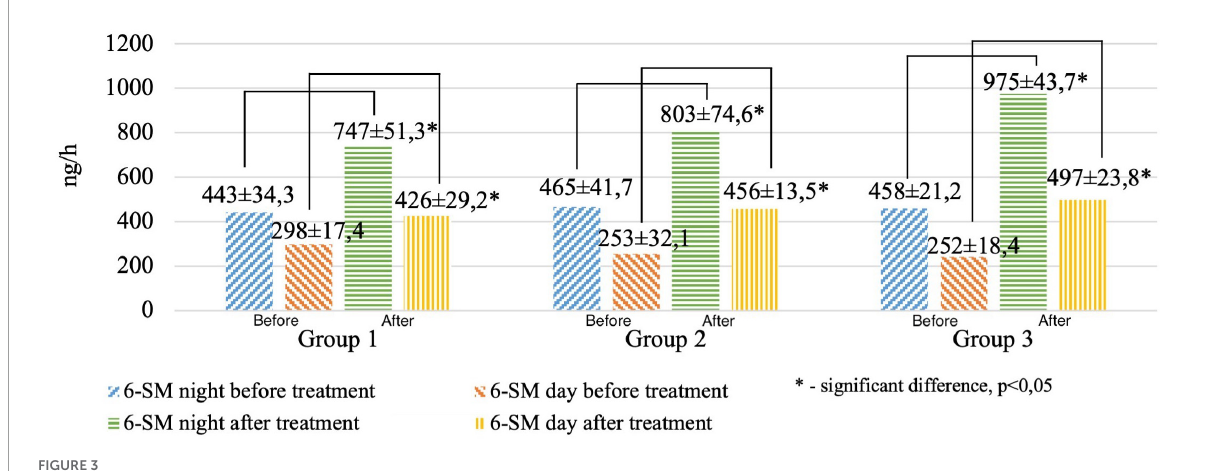
TABLE 1 Comparative characteristics of patient groups according to daily monitoring of blood pressure (DMBP) data before and after treatment (Student’s t -test). Nighttime blood Number of cases, % Statistical data pressure, % Group 1 Group 2